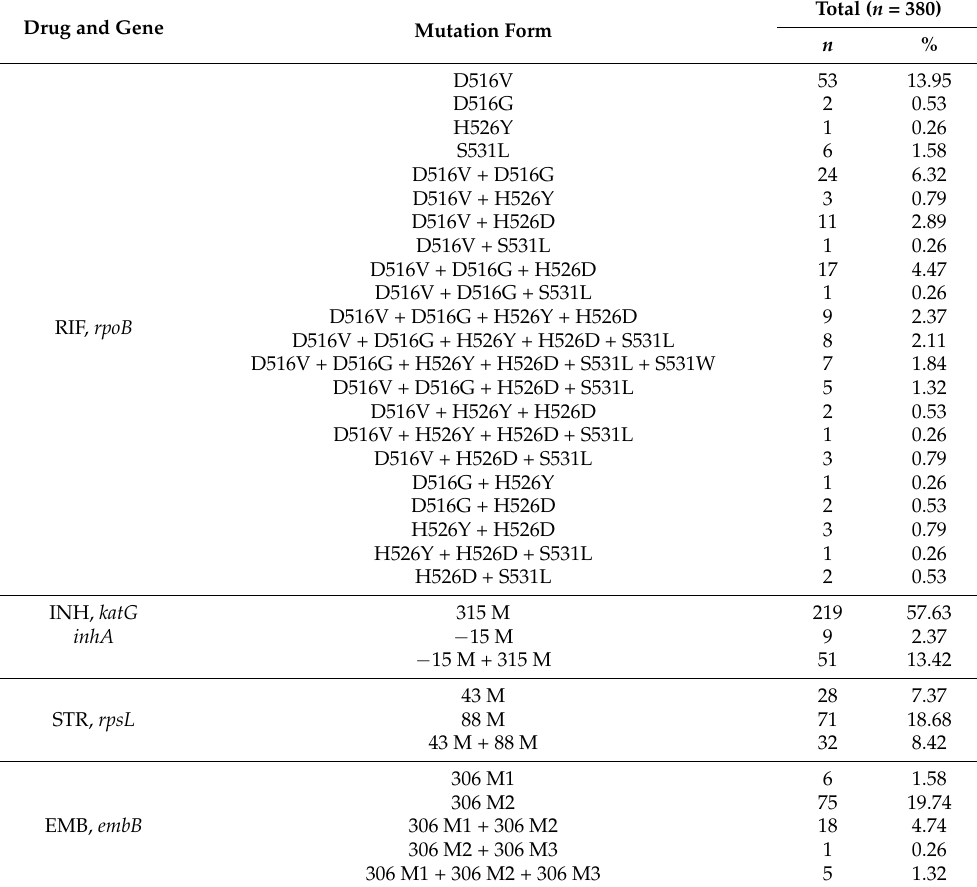
Table 4. Mutations in drug resistance-related genes.